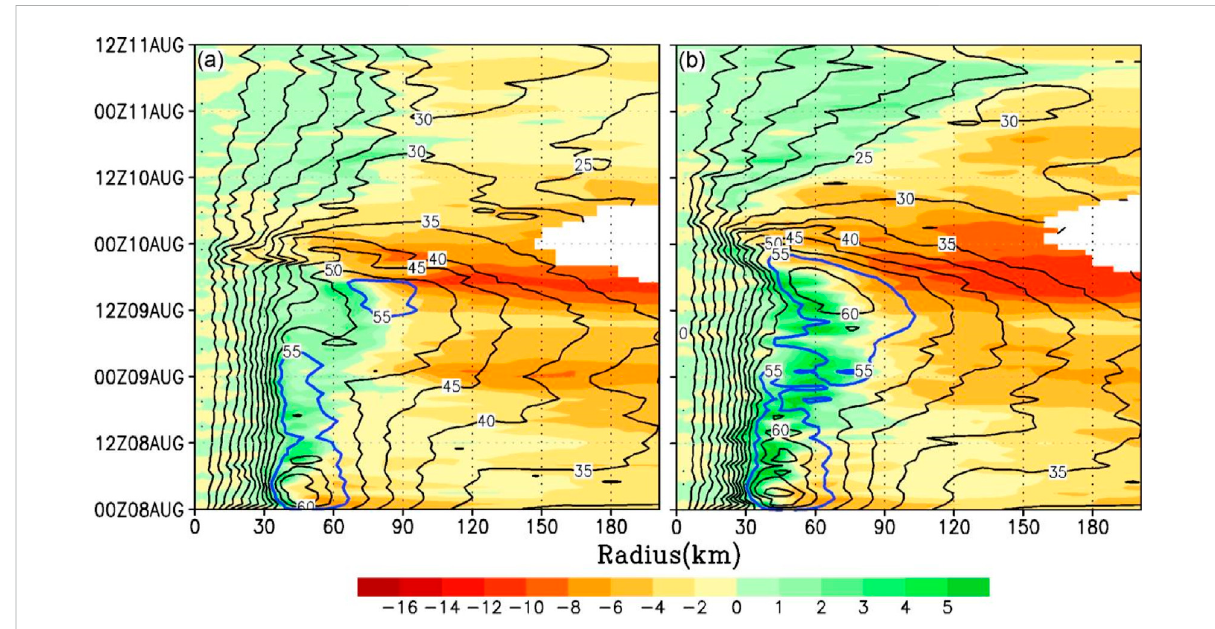
FIGURE 7 Radius – time evolution of the azimuthal-mean radial wind (shaded, unit: m s − 1 ) and tangential wind (contour, unit: m s − 1 ) at 1 km altitude in the (A) CTL and (B) PBL1 experiment. The white areas denote missing